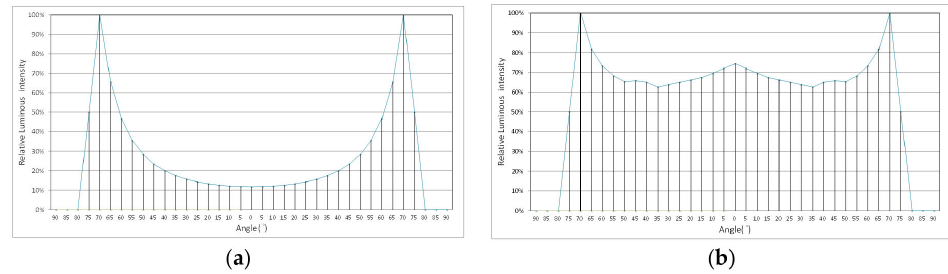
Figure 10. The targeted photometric curve of a roadway lighting lens: ( a ) Type A; ( b ) Type B. Table 5. The configuration of a ray path: (a) Type A; (b) Type